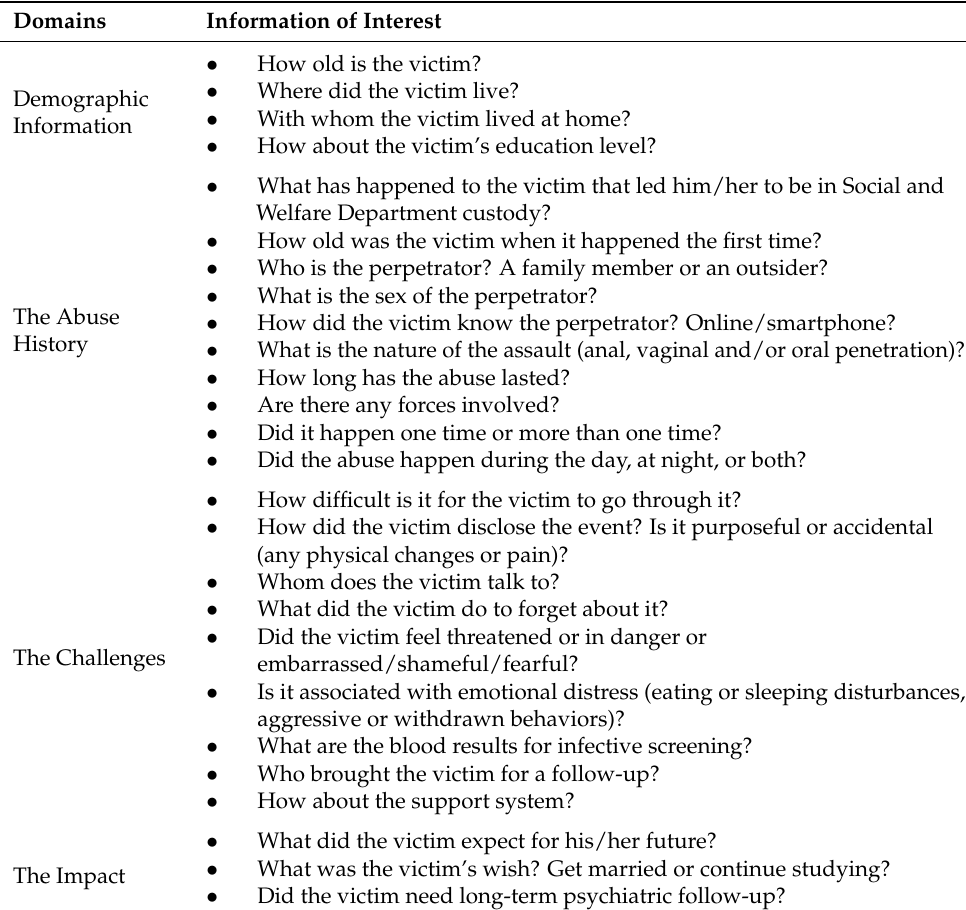
Table 1. Case record data extraction